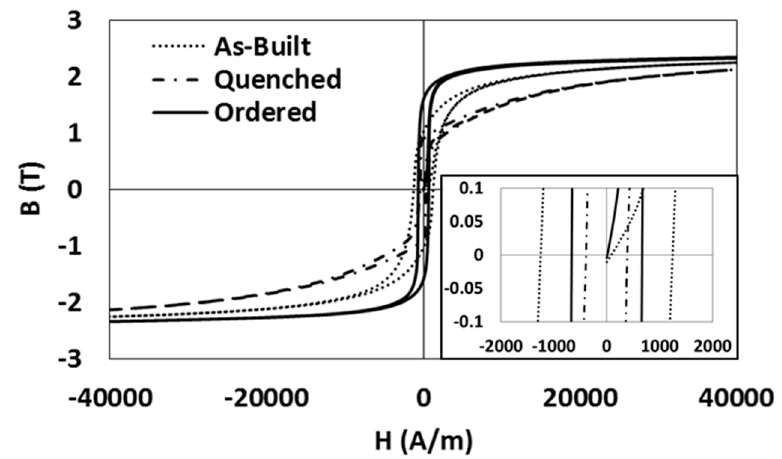
Figure 6. Representative hysteresis loops for AM samples for various heat treatment conditions. The inset figure illustrates the differences in coercivity.